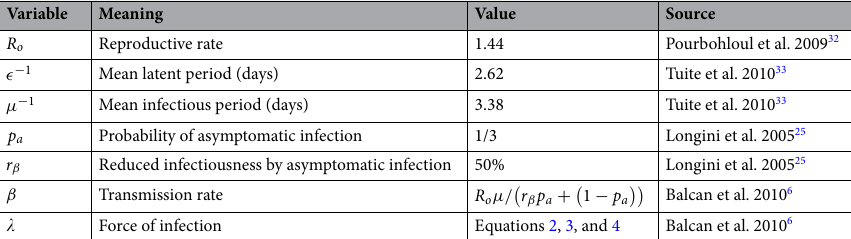
Table 1. Disease parameter values used in the modeling process.